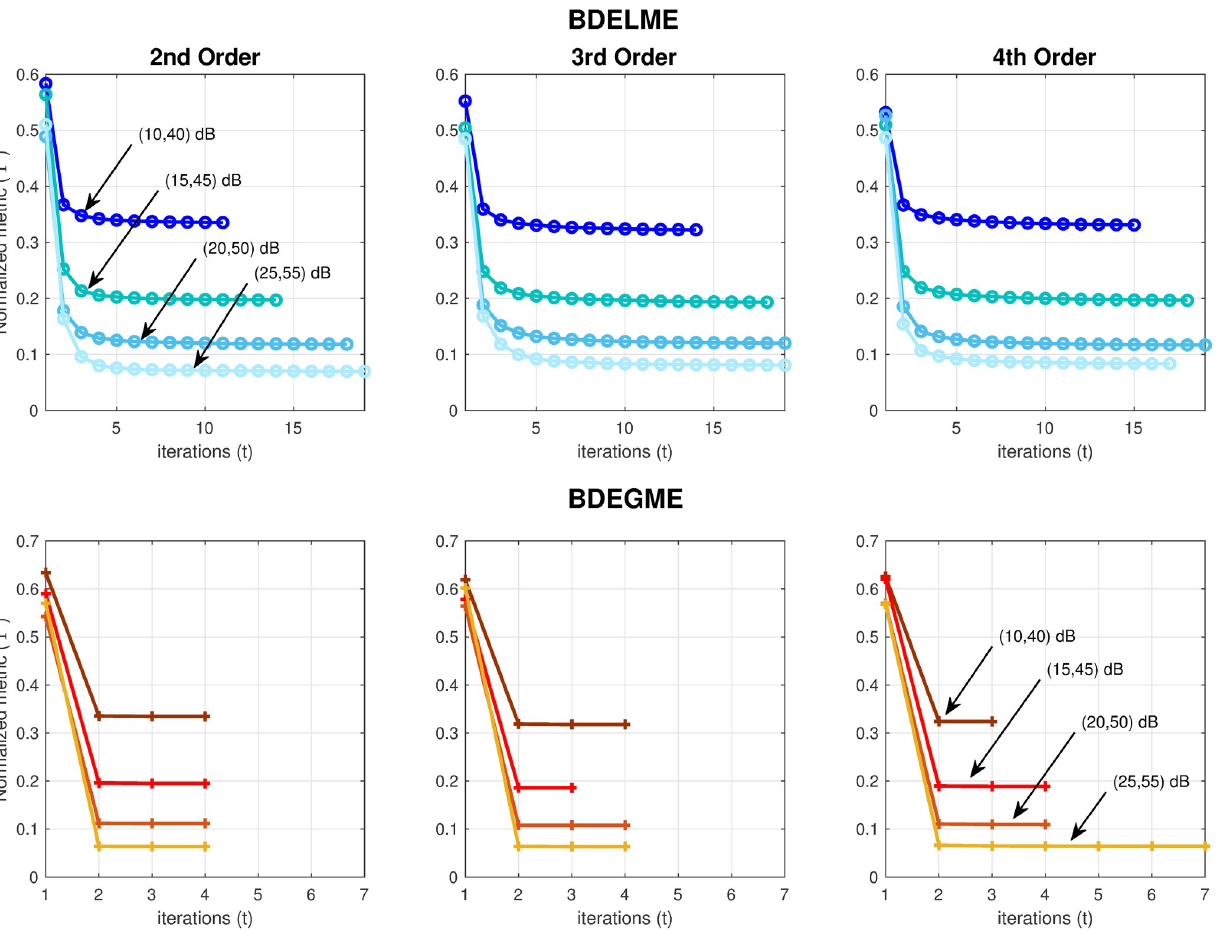
Fig 4. Normalized metric (Y t ) vs iteration ( t ) in the ALS scheme for (top row) BDELME and (bottom row) BDEGME by considering synthetic FLIM datasets at different noise levels (SNR,PSNR) 2 {(10, 40), (15, 45), (20, 50), (25, 55)} dB, and impulse response orders (2nd, 3rd and 4th).